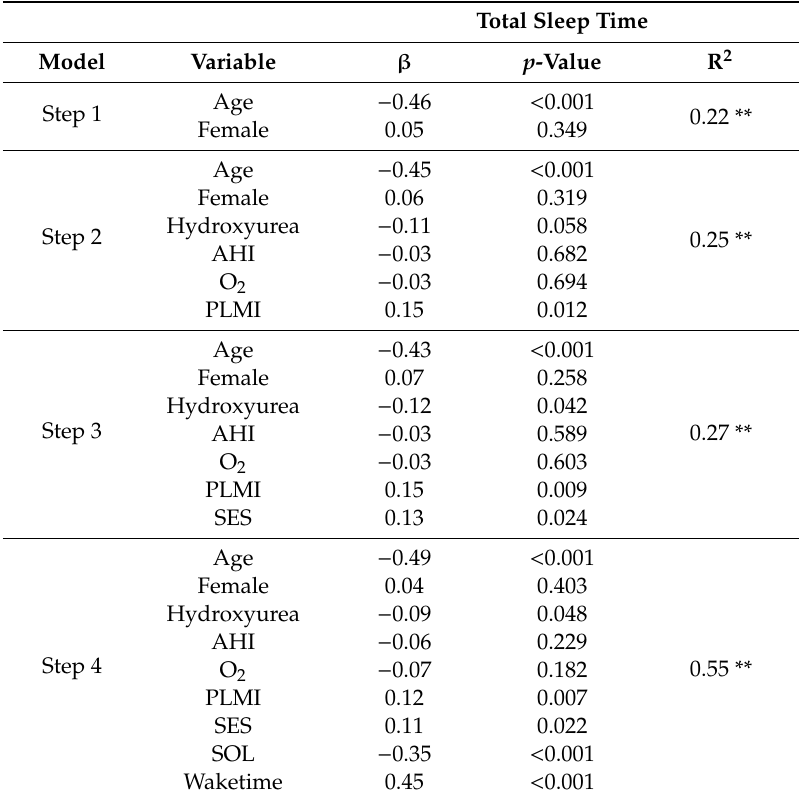
Table 7. Hierarchical multiple regression predicting total sleep time (CSHQ) at